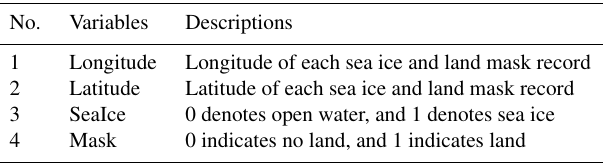
Table 2. List of variables and their descriptions in the NetCDF